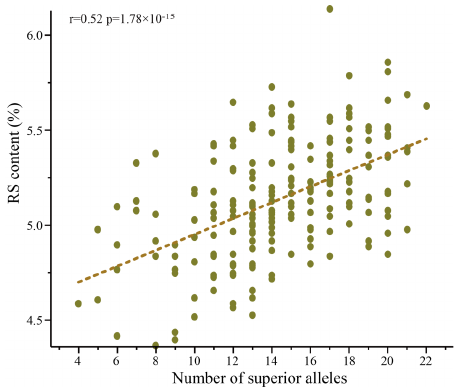
Figure 4. Additive effect of the superior alleles to the RS content in the association population. Correlation analysis between the number of superior SNP alleles and RS content. The dots represent varieties with various superior alleles; the RS content was marked on the y -axis accordingly. The dotted line represented fitted correlation line. The green dots showed varieties in the association